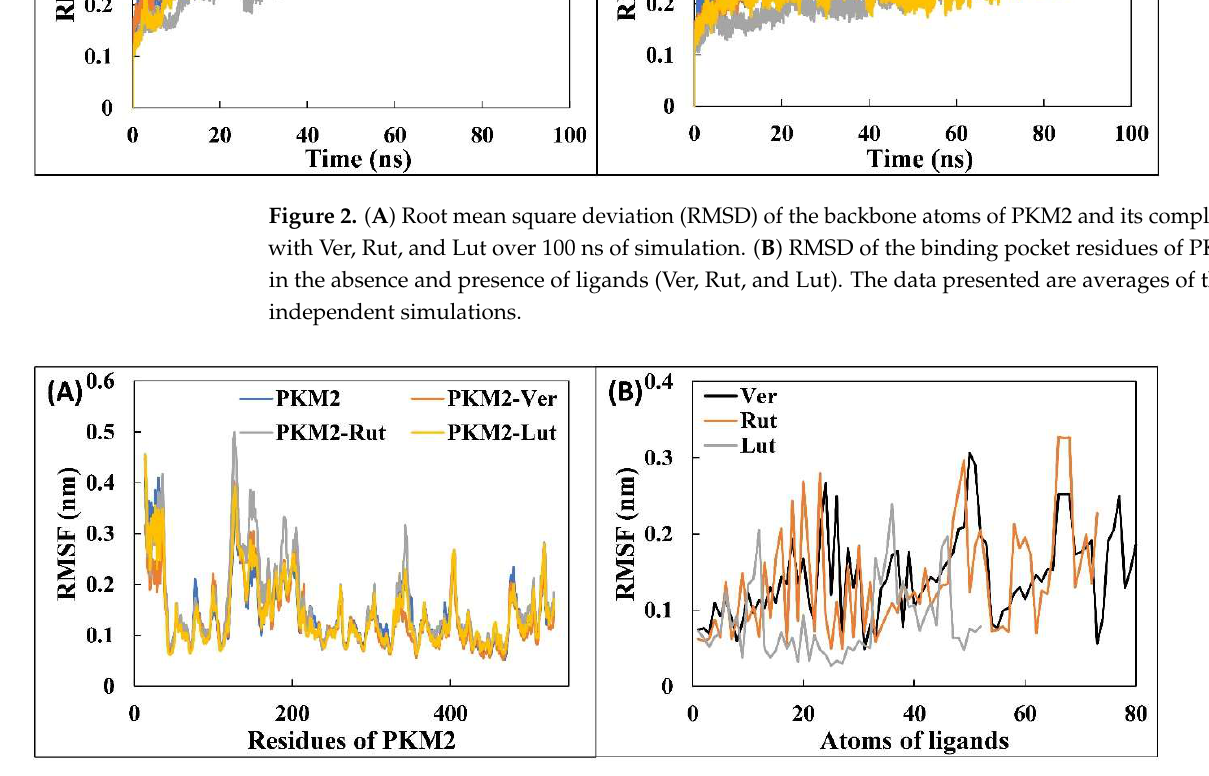
Figure 3. ( A ) Root mean square fluctuation (RMSF) of Cα of each residue of PKM2 and its complexes with the Ver, Rut, and Lut. ( B ) The average RMSF of each atom of ligands (Ver, Rut, and Lut). The data presented are averages of three independent simulations.